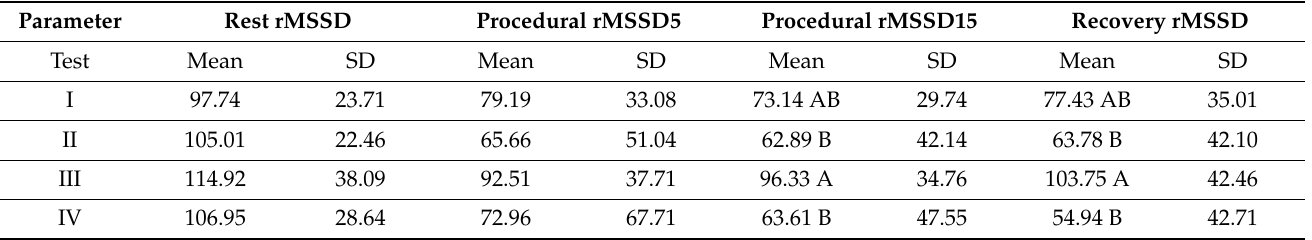
Table 6. rMSSD (root mean square of successive differences between consecutive RR intervals) during consecutive